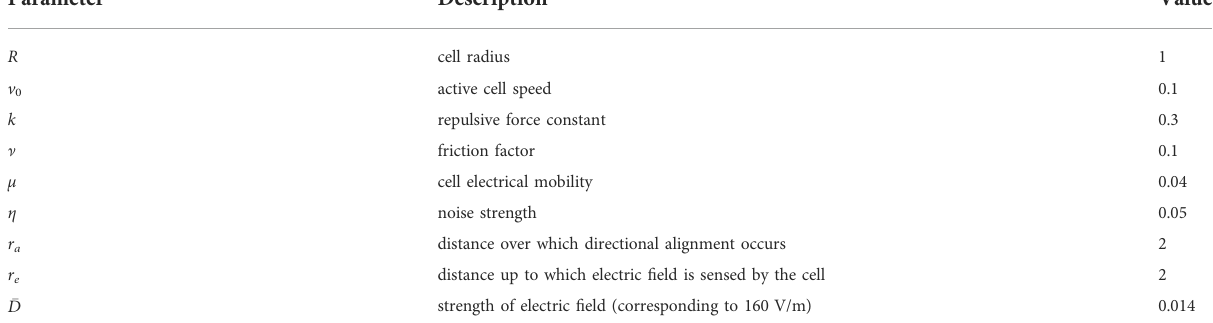
TABLE 1 List of all the model parameters used in simulations, their notation, description and value (dimensionless).